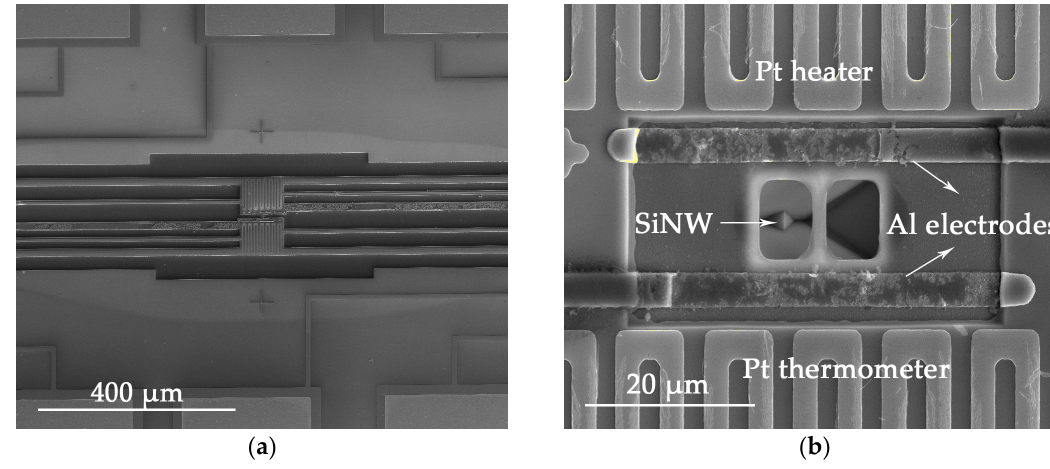
Figure 6. ( a ) SEM image of the device; ( b ) Nanowire suspended between two Pt serpentine resistances with Al metal electrodes.